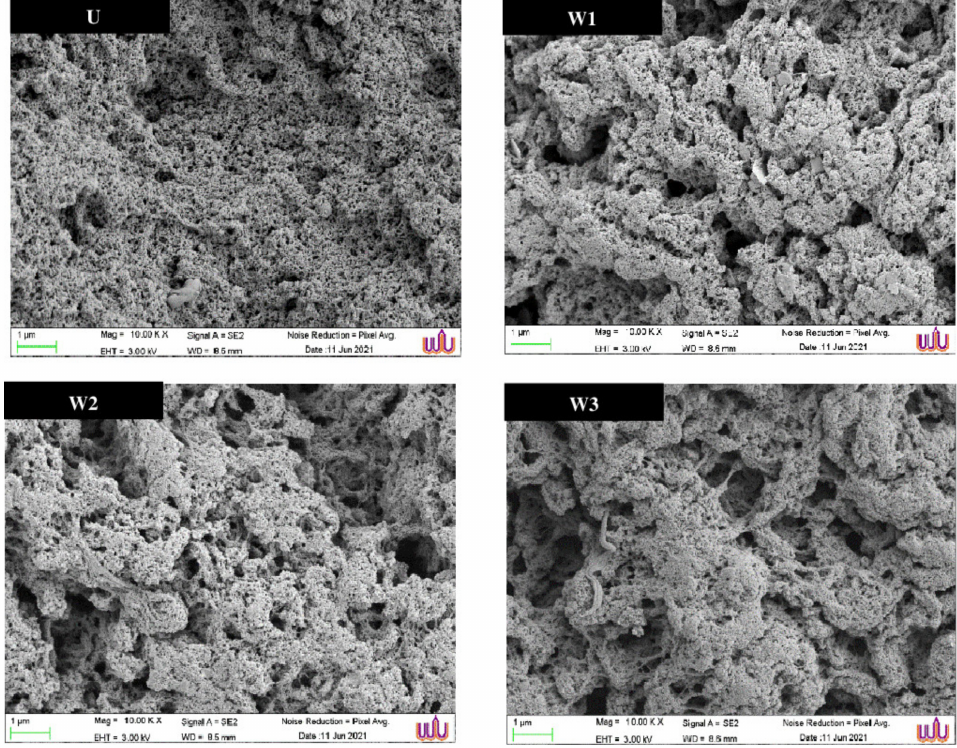
Figure 5. Scanning electron microscopic (SEM) images of gels from unwashed mince (U) and surimi from Indian mackerel prepared by one washing cycle (W1), two washing cycles (W2), and three washing cycles (W3). (Magnification: 10,000 × , EHT: 3